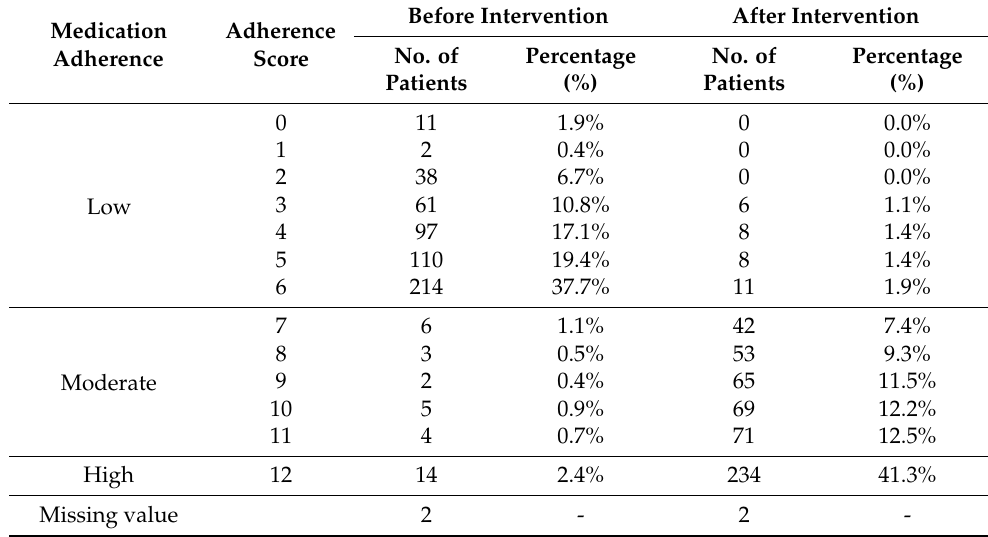
Table 4. Patients’ medication adherence ( N = 569).